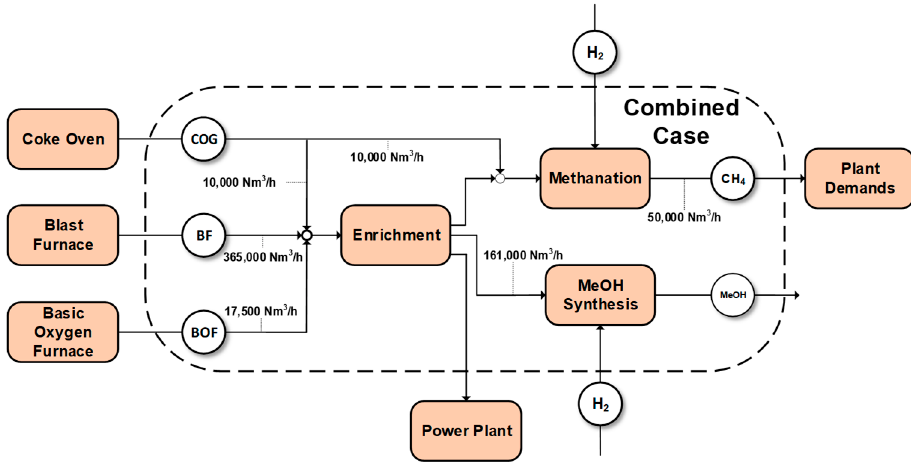
Figure 4. The combined case: replacement of natural gas demands and methanol synthesis.